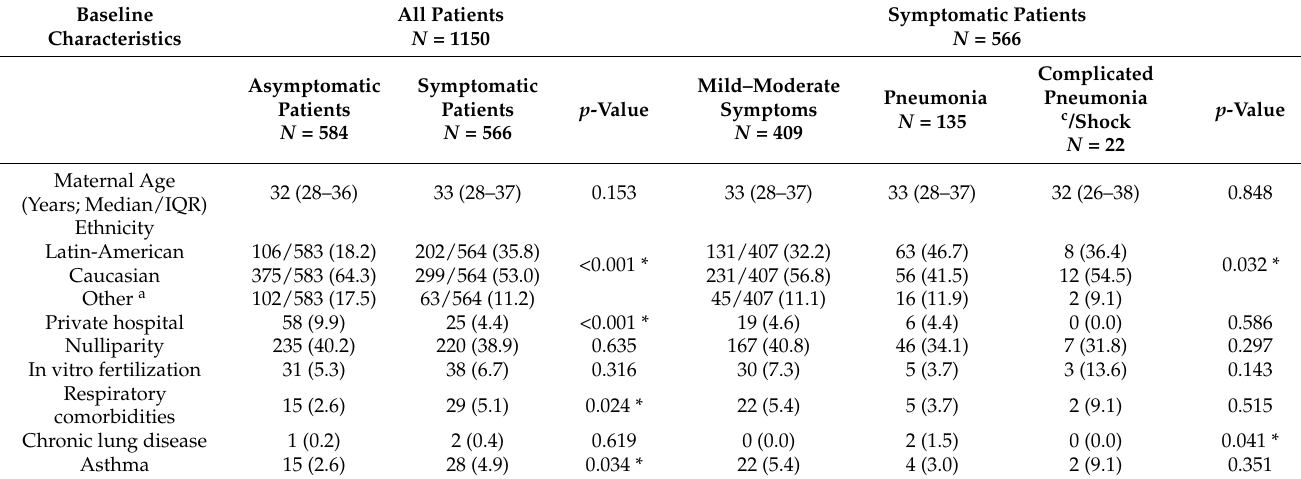
Table 3. Baseline characteristics by clinical presentation of SARS-CoV-2